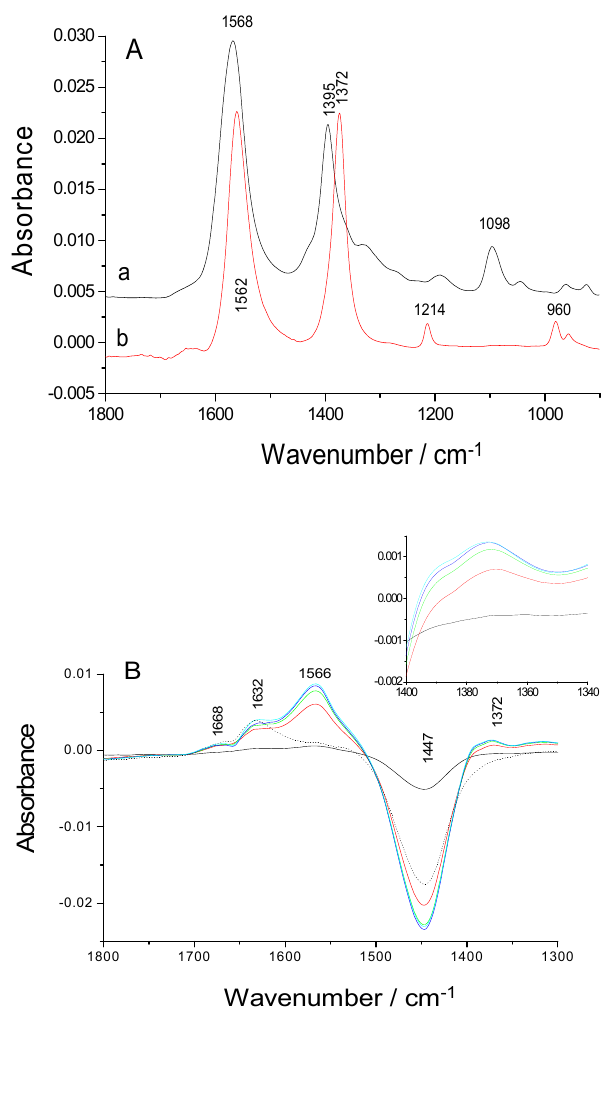
Figure 2. (A) Infrared spectra of 100 mM malate (trace a) and fumarate (trace b) in H pH 7.5. (B) Series of overlaid spectra of infrared absorbance changes due to the malic acid to fumarate reaction. The solid line spectra were recorded at 12 s (black), 4 min (red), 8 min (green), 16 min (blue) and 30 min (cyan) and the dotted line spectrum is the last spectrum of the control experiments without malic acid (30 min). The insert in panel B is an expanded view of the 1372 cm -1 band. (C) Kinetics of the enzymatic reaction of fumarase, monitored by the integrated band intensity at 1372 cm -1 for reaction (black) and the control (red)